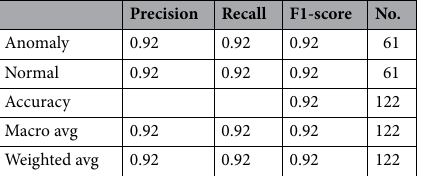
Precision Recall F1-score No.